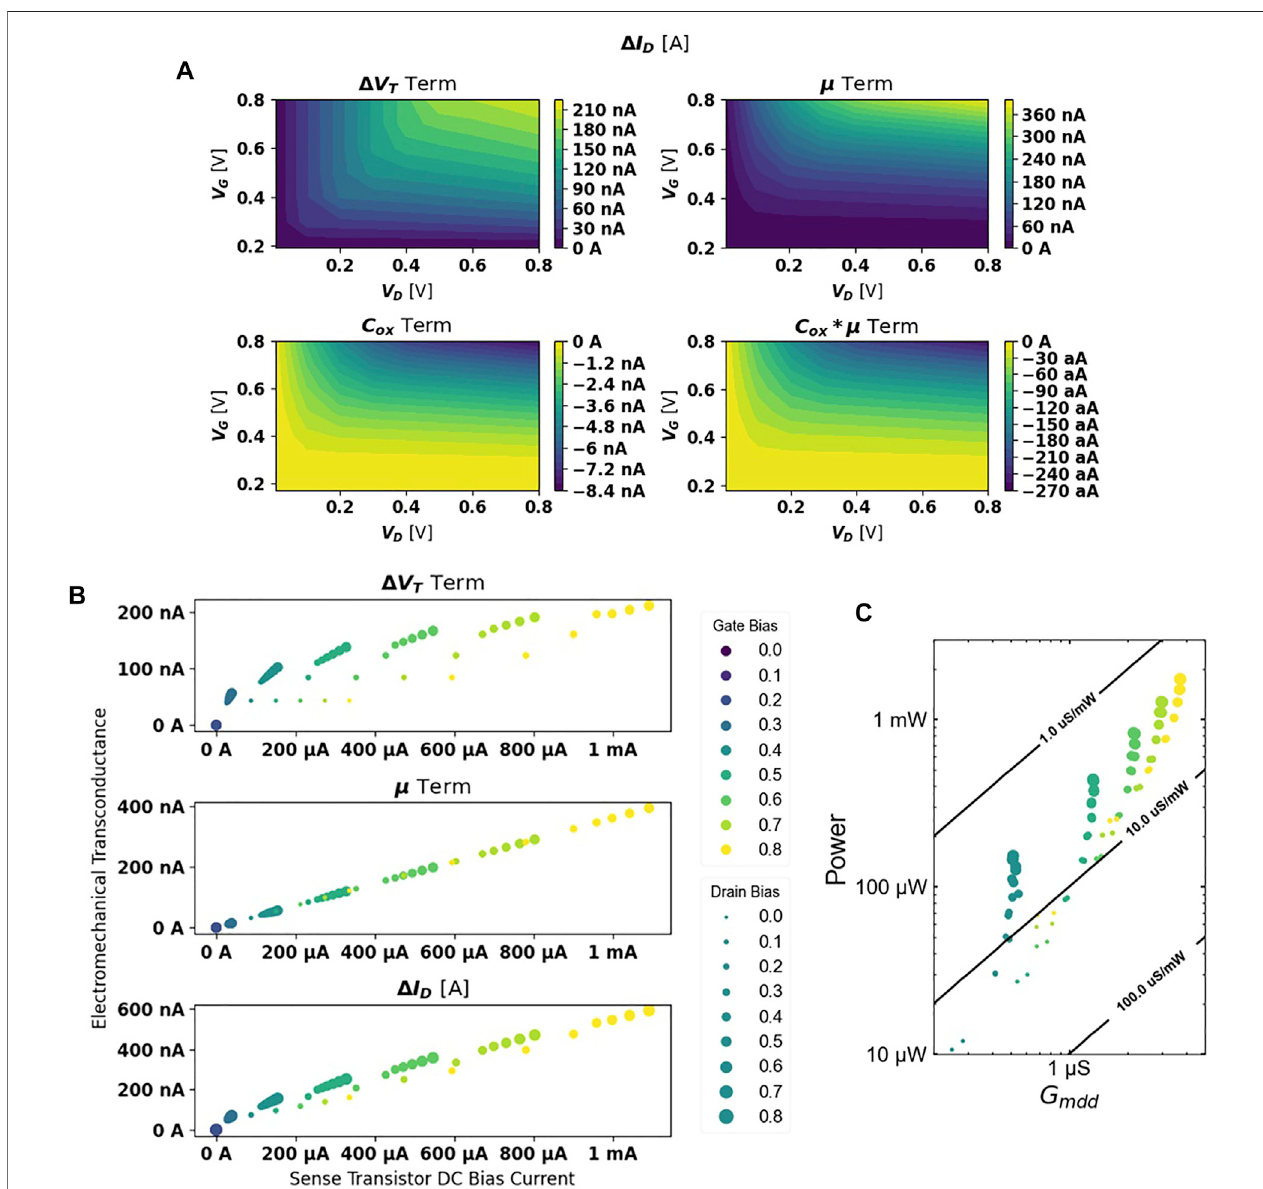
FIGURE 8 | (A) Predicted contributions from bandgap and piezoresistive modulation show an ≈ 800× improvement in sense transduction over standard dielectric transduction. (B) Piezoresistive contribution scales linearly with drain current, while the bandgap modulation term is maximized by setting V D as high as possible for a given V G . (C) DC power required for a given G mdd . Iso-ef fi ciency contours show degrading power ef fi ciency for larger required G mdd . For a given required transconductance, designers can maximize power ef fi ciency by biasing at high gate voltage and low drain bias. Adapted from (Anderson et al., 2021; Anderson et al.,